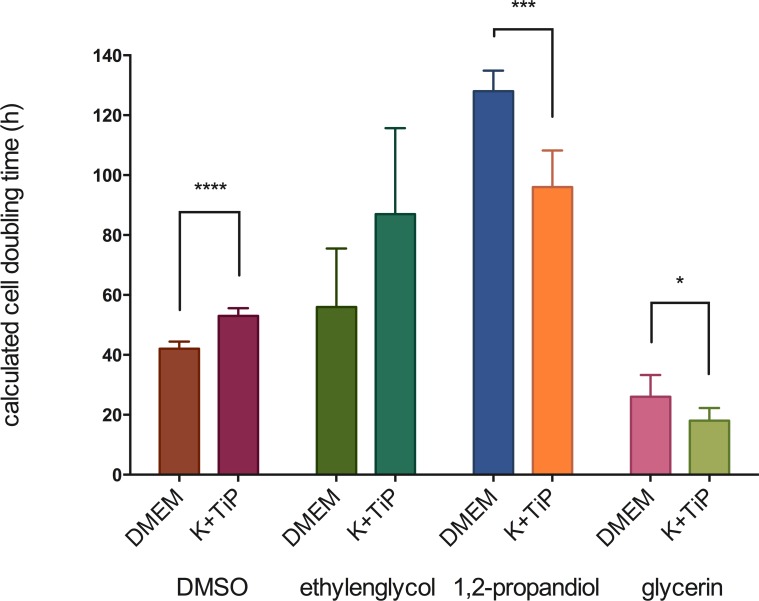
Cell doubling-time after vitrification.Figure 6 illustrates MHEC-5T doubling-time after vitrification. DMEM = DMEM Ham’s F-12 Gln+, 20% FBS, and 3M of one of the CPAs; K+TiP = K+TiP. 0.5M sucrose, 20% FBS, and 3M of one of the CPAs; * = significant (p < 0.05); *** = highly significant (p < 0.001); **** = highest siginificance (p < 0.0001).